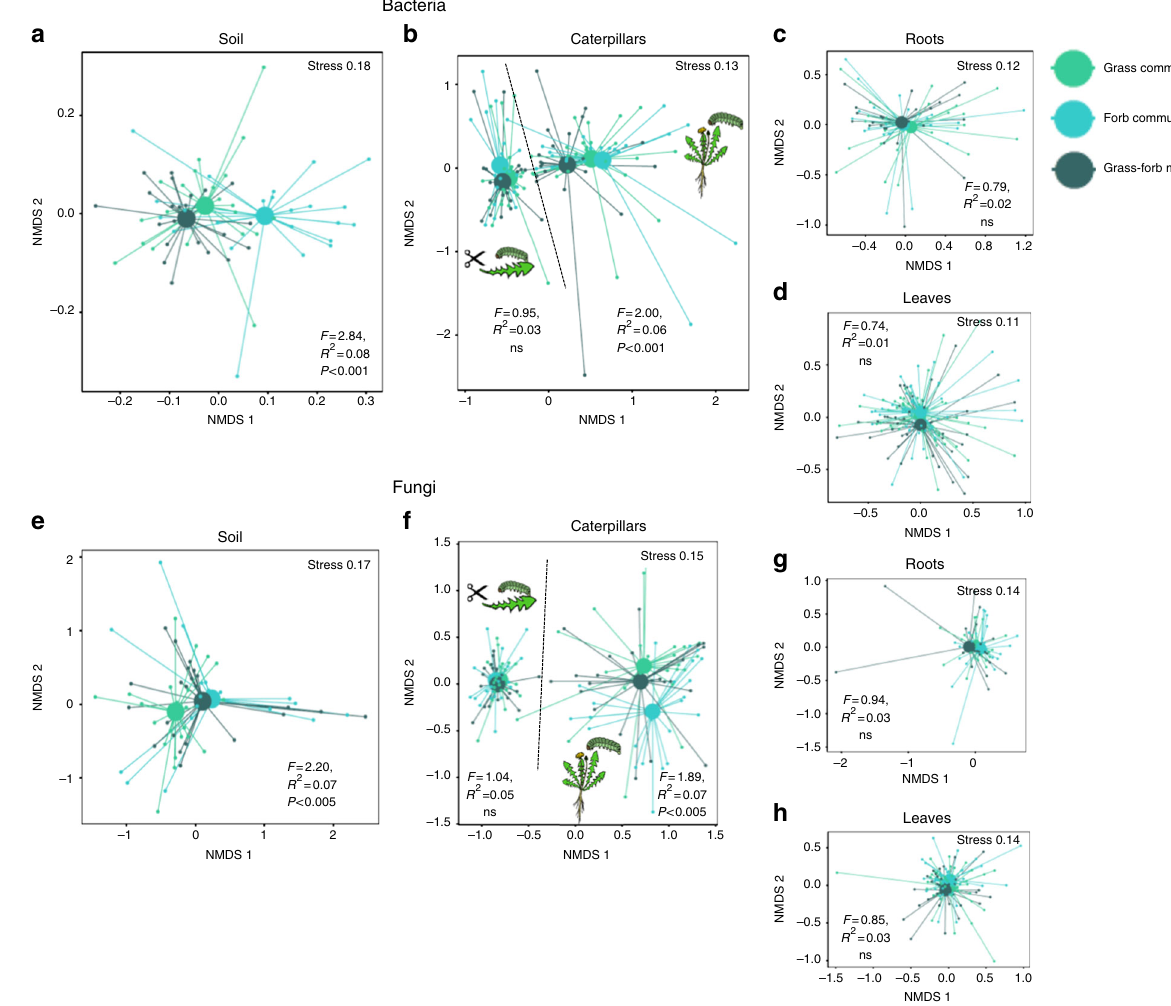
Fig. 3 Legacy effects of plant communities on microbiomes. Plant community identity effects on bacterial a – d and fungal ( e – h ) communities in caterpillars, leaves, roots, and soil. NMDS plots are presented based on Bray – Curtis similarity. The 2D stress value for each panel ranges between 0.11 – 0.18. Soils originating from grass communities are presented with light green symbols, soils from forb communities with turquoise symbols and soils from mixed grass and forb communities with dark green symbols. In each panel, smaller symbols depict individual samples, centroids are depicted with larger markers. Signi fi cance of the plant community treatment effect based on a PERMANOVA is also presented in each panel. a , e represent the composition of microbiomes in soils, b , f microbiomes in caterpillars both on intact plants and on detached leaves. c , g microbiomes in roots and d , h microbiomes in leaves. The effect of plant community growth rate (fast- and slow-growing communities) is shown in Supplementary